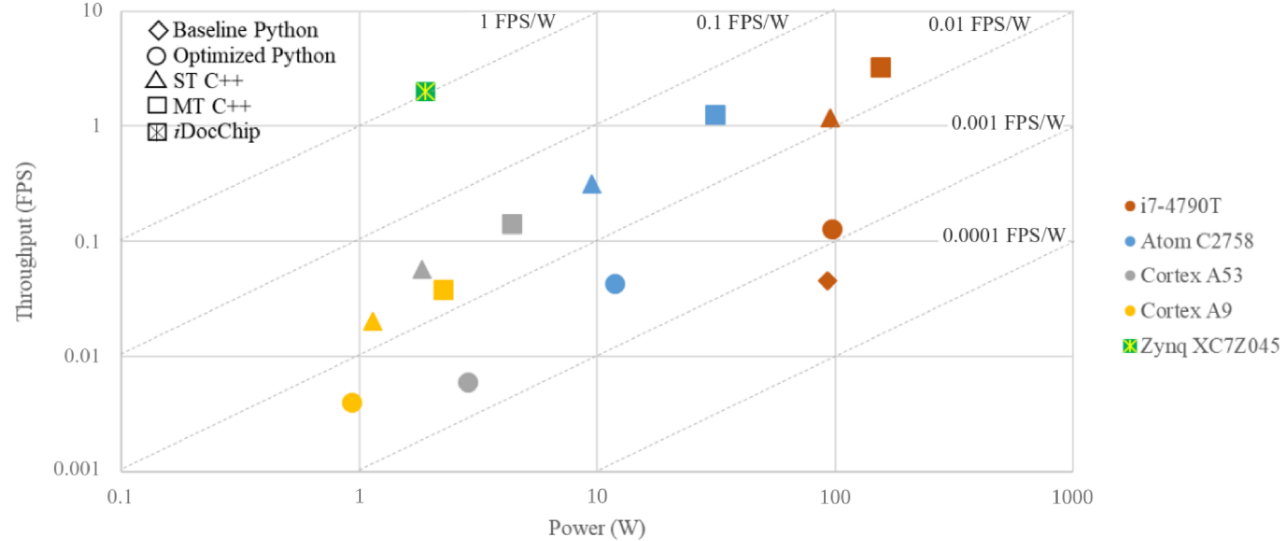
Figure 28. Power vs. FPS comparisons of the reference anyOCR and the optimized i DocChip algorithm on different platforms. The grid lines show energy efficiency in